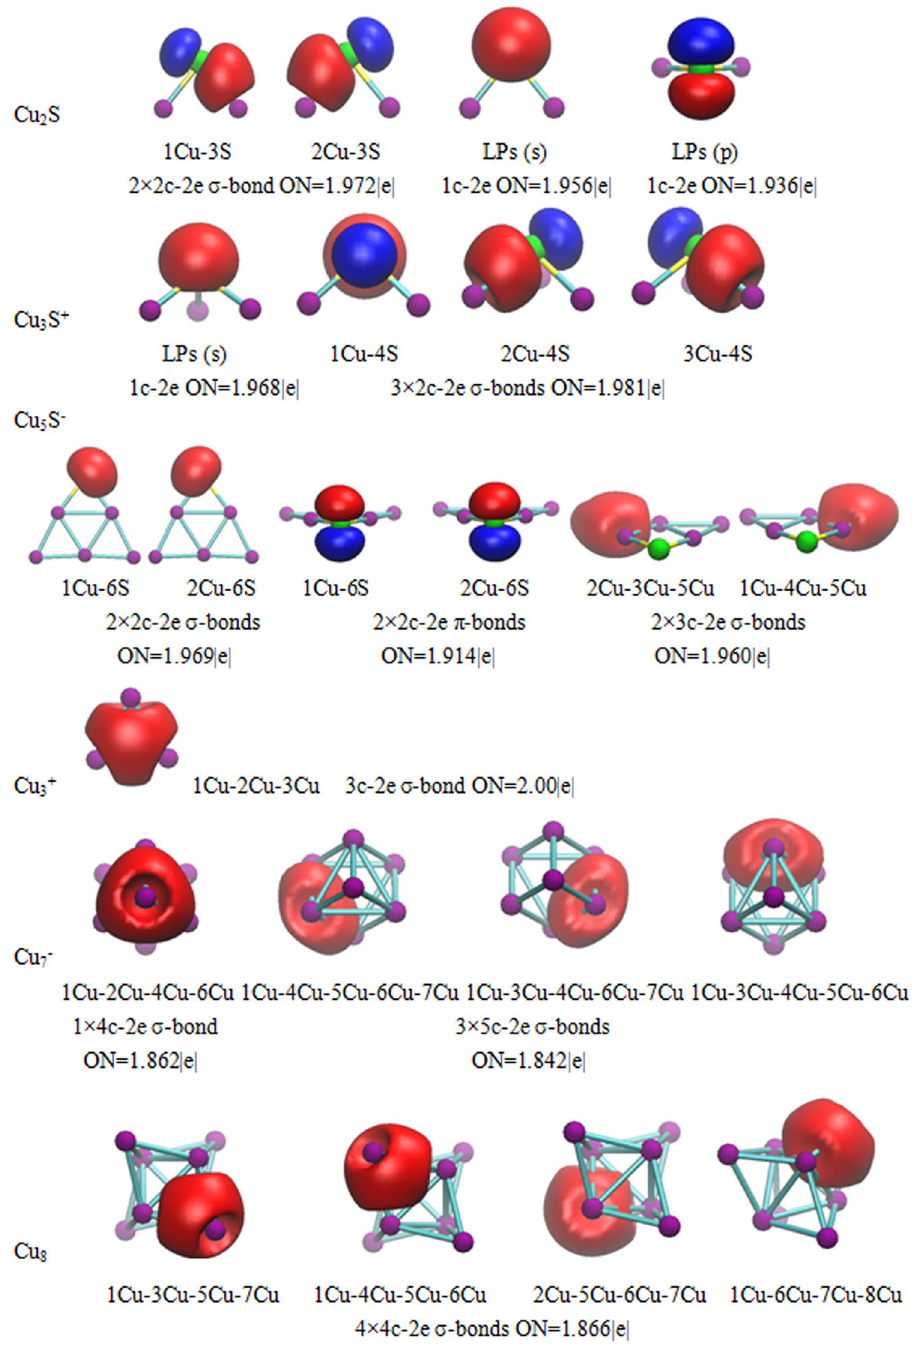
Figure 5. AdNDP chemical bonding analysis of the Cu 2 S, Cu 3 S + , Cu 5 S − , Cu 3 + , Cu 7 − and Cu 8 clusters. ON denotes occupation